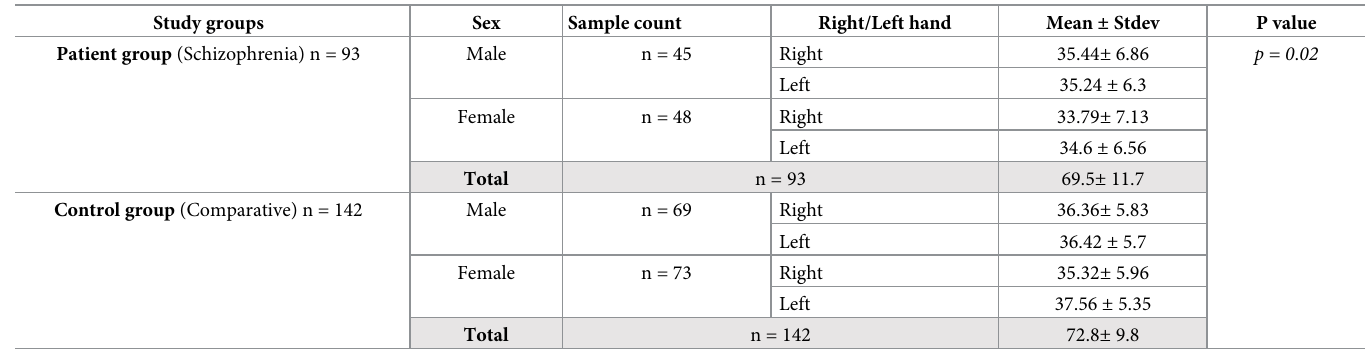
Table 6. Mean of A-B ridge